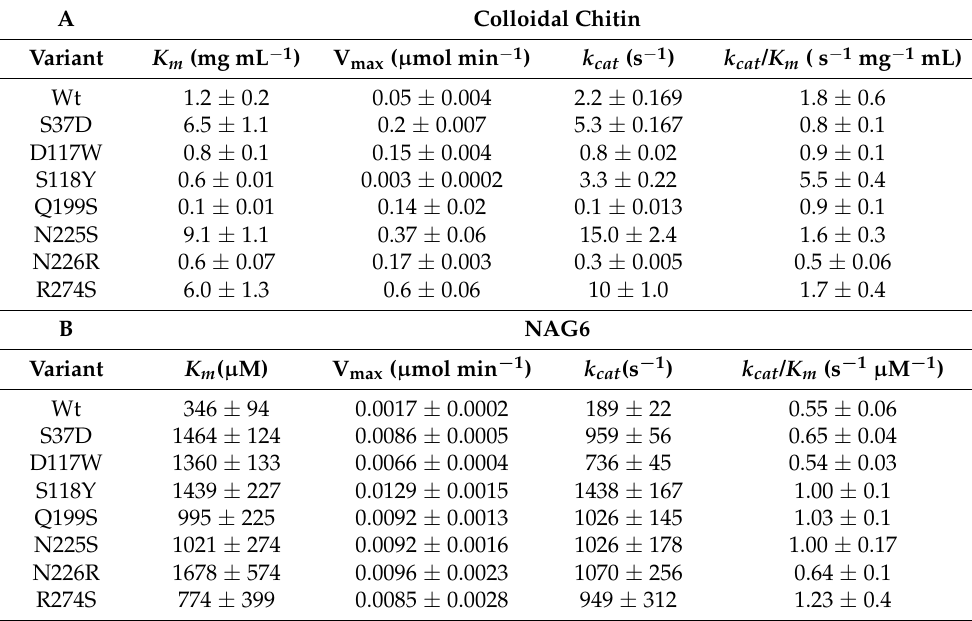
Table 1. Kinetic parameters on colloidal chitin (A) and NAG6 (B) of the referred variants. A Colloidal